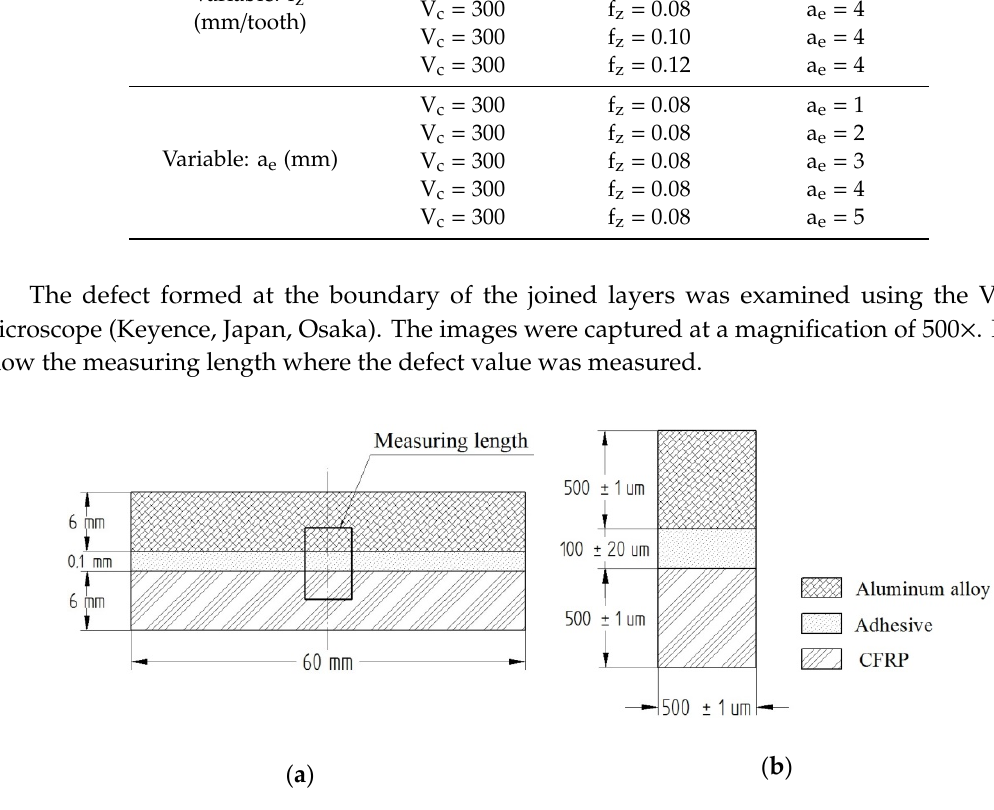
Table 3. Technological parameters of milling.